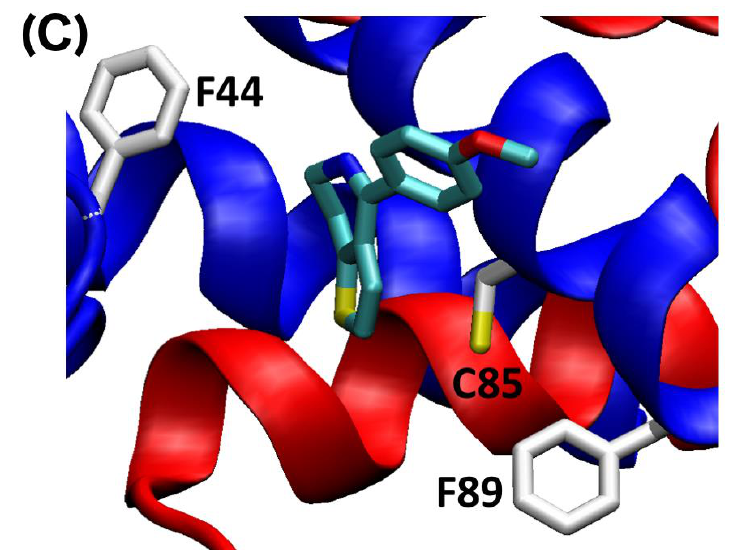
Figure 7. Predicted binding mode of ( A ) BTB10184 ( B ) KM01765 and ( C ) SEW01483 for Ca 2+ -S100A1. Residues in the pocket with large spectral perturbations are labeled. The two subunits of the S100 protein are colored in blue and red, respectively.